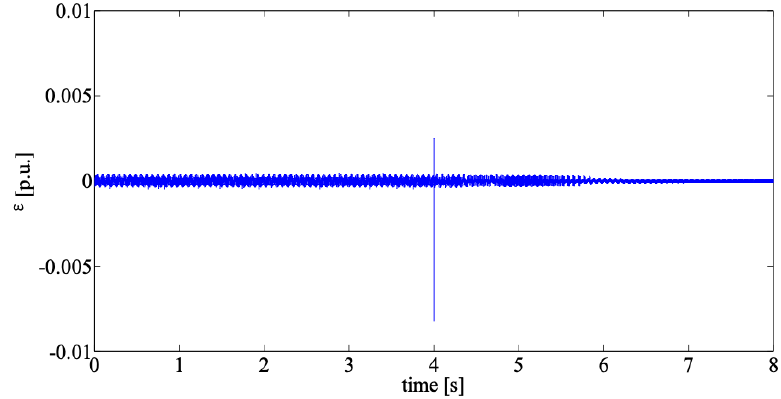
Figure 19. Error between the actual magnetizing current and the estimated current (case B).